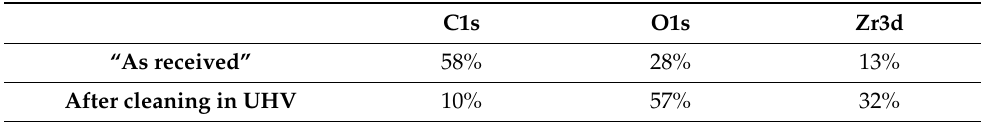
Table 6. The atomic concentration of the ZrO 2 film obtained for “as received” layer and after cleaning by argon ion beam.